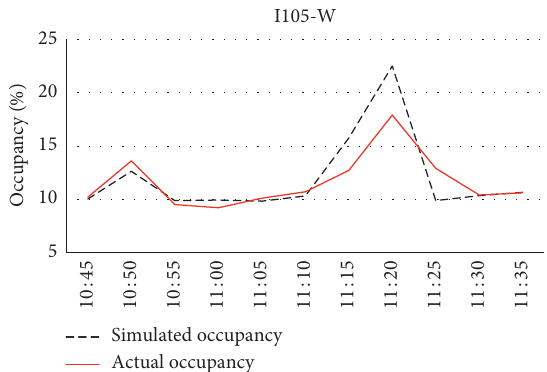
Figure 9: Actual and simulated occupancy comparison at freeway